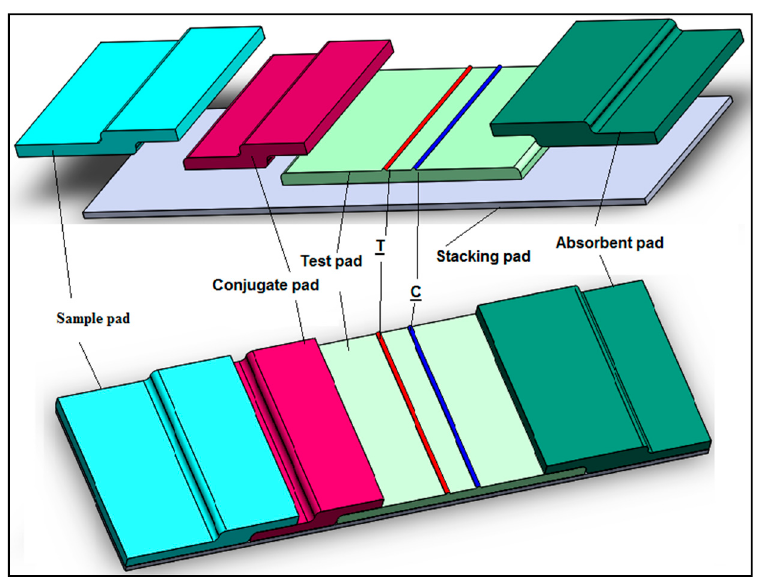
Figure 2. Schematic representation of a typical lateral flow assay (LFA) that is composed of four types of membrane.